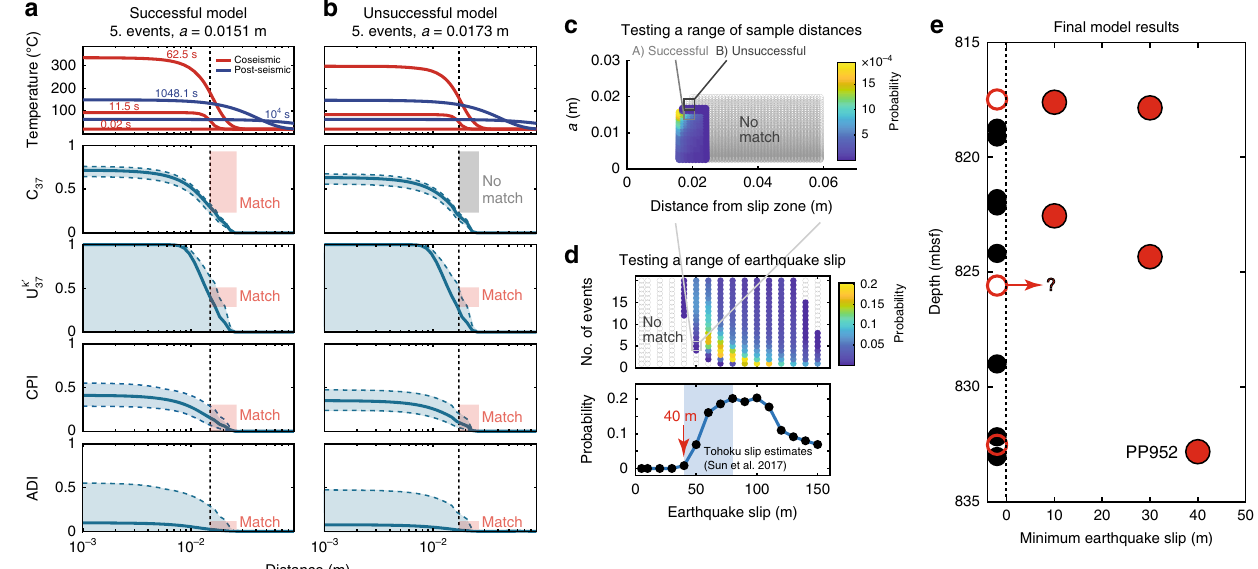
Fig. 3 Modeling slip to match biomarker measurements. The forward modeling procedure considers variation in fault half width, slip magnitude, number of earthquakes, and distance of a sample from the fault. Here, we show an example for sample PP952, assuming fi ve earthquakes with slip of 50 m. a A successful model fi t for all biomarkers using a = 0.0151 m. The fi rst panel shows the temperature with distance from the fault for different time-steps. Lower panels show the fi nal biomarker fraction reacted with distance from the fault (heavy lines) with blue shaded regions showing uncertainty in biomarker kinetics. Measured range of each biomarker anomaly is shown as boxes (height). The width of the boxes represents the sample width, limited by the constraint that the sample is outside of the slipping zone. Boxes are shaded red for successful matches and gray if unsuccessful. b Model is unsuccessful for a = 0.0173 m due to a mismatch between modeled and measured C 37 total fraction reacted. c Plot of distance from the fault vs. half width with hotter colors showing higher probability of a successful model (successful models/total model runs). Gray circles indicate unsuccessful models ( P = 0). d Lower panel shows the probability of a successful model at the range of earthquake slips tested. Minimum slip with a nonzero probability is indicated with the red arrow. Range of slip estimates for the Tohoku-Oki earthquake shown by the blue shaded region 4 . Upper panel shows the slip vs. number of earthquakes with probability indicated by color as in c . e For samples with biomarker anomalies we fi nd the minimum slip distance of a repeating event (up to 3.2 km of total displacement) needed to match the biomarker anomalies. These modeling results indicate that any of the faults with heating anomalies could have hosted the 2011 Tohoku-Oki earthquake, and that all observed biomarker anomalies require earthquakes with a minimum of 10 m slip per event. Red symbols indicate features with clear biomarker anomalies. Hollow red symbols represent sample PP948, which has alkenone concentrations below the quanti fi cation limit and is not modeled (Supplementary Note 3) and samples PP944 and PP951 for which structural evidence is ambiguous (Supplementary Note